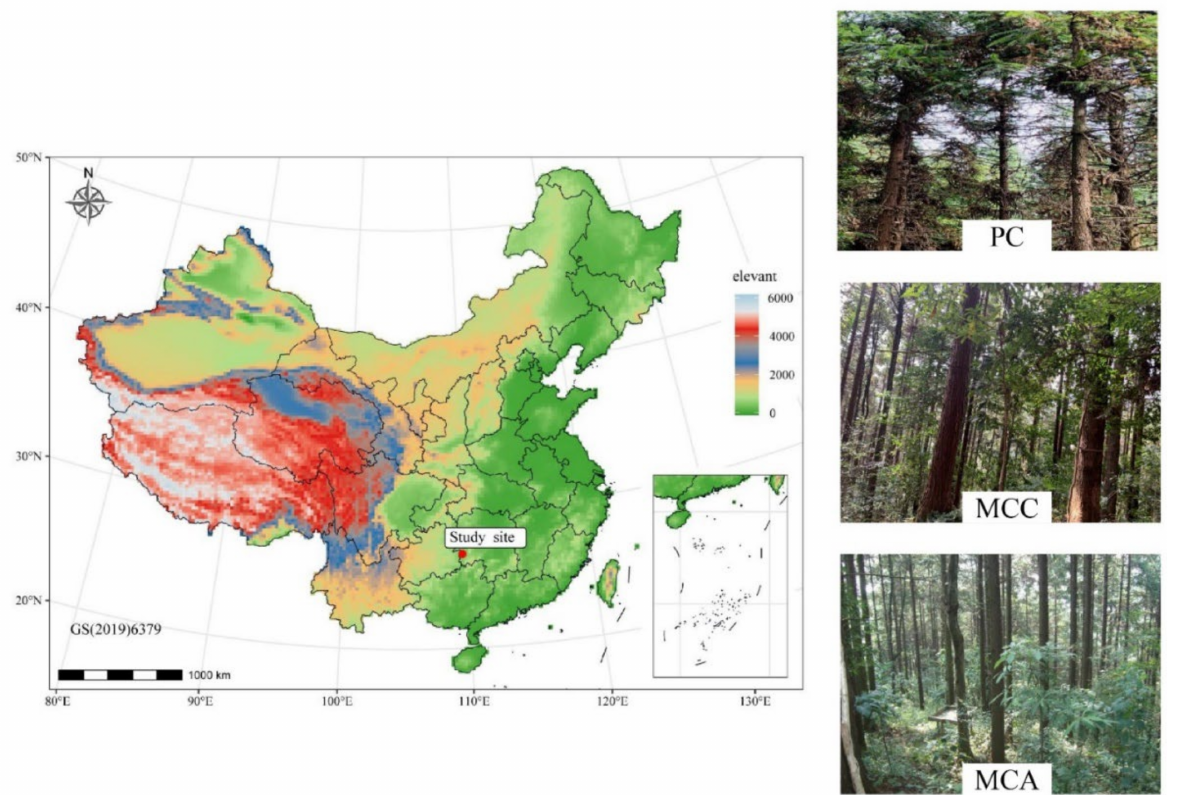
Figure 1. The geographical location of the study site and the landscape of different Chinese fir planta- tions. PC: pure C. lanceolata plantation; MCC: mixed plantation with C. lanceolata and C. camphora ; MCA: mixed plantation with C. lanceolata and A. cremastogyne